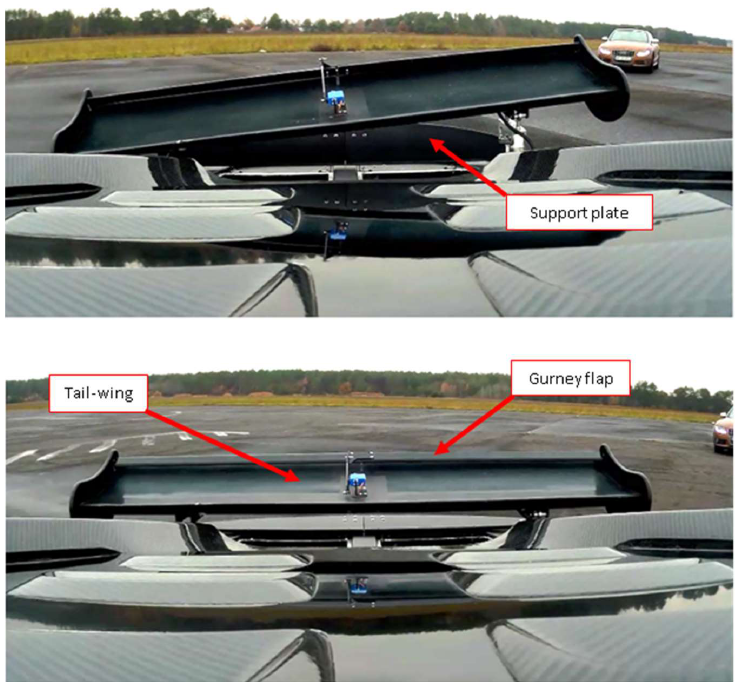
Figure 32. Rear aerodynamic add-ons: inverted wing, support (booster) plate, and movable Gurney flap (top configuration—maximum, and bottom configuration—minimum).